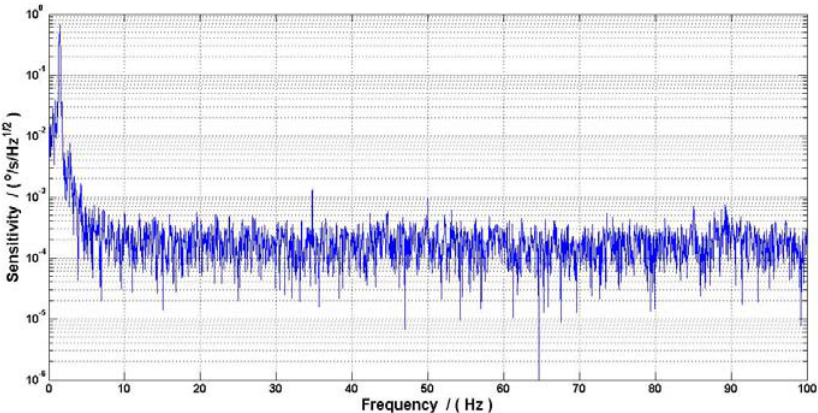
Figure 5. The Fourier spectrum of the ASG